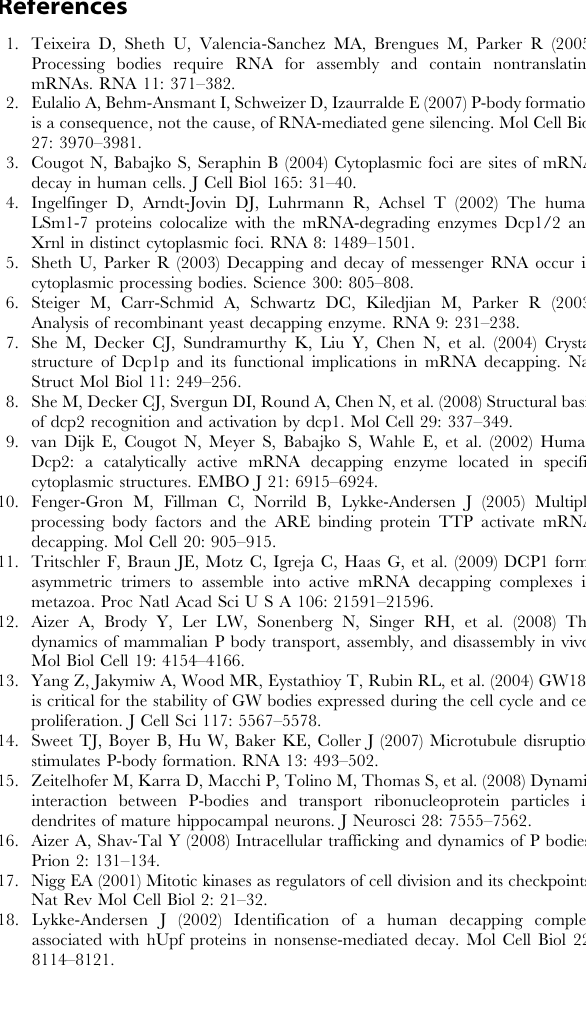
Figure S3 Mutation S315A reduces hyper-phosphoryla- tion of GFP-Dcp1a. (A) No hyper-phosphorylation of hDcp1a S315A mutated protein was observed in mitotic cells (Noc) expressing GFP- hDcp1a S315A (100 kD) compared to the endogenous Dcp1a protein (70 kD) which did show hyper- phosphorylated Dcp1a bands. The blot was reacted with anti- Dcp1a. (B) The S319A and S522,523A mutated GFP-Dcp1a proteins showed prominent hyper-phosphorylation patterns com- pared to the S315A protein. Tubulin was used as a loading control.